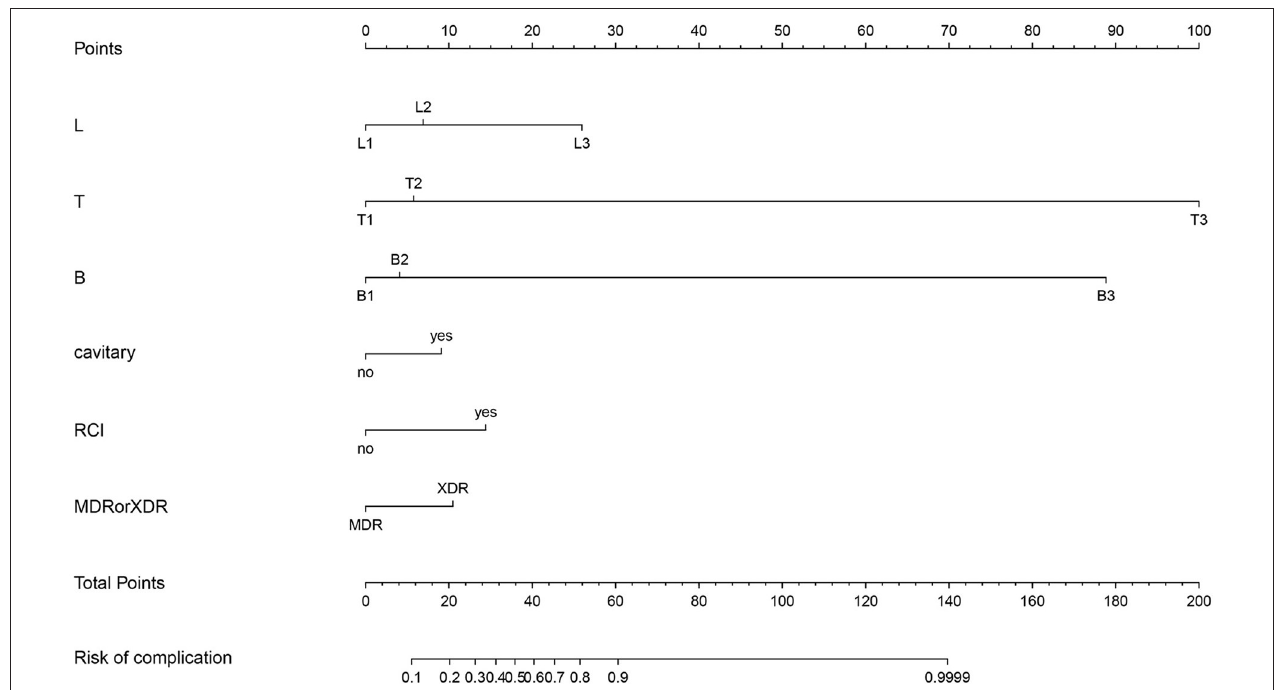
FIGURE 2 | Developed postoperative complication nomogram. L, Lesion; T, Treatment history; B, Body condition; RCI, Recurrent chest infection; MDR/XDR, Multi drug resistant/extensively drug resistant.